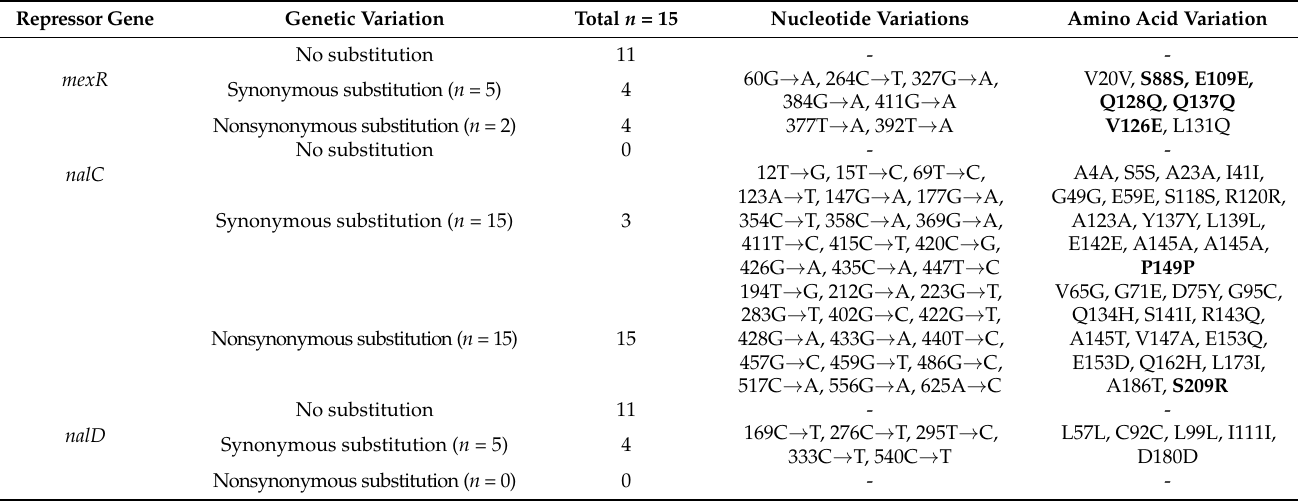
Table 3. Substitutions identified in the mexR , nalC , and nalD repressor genes in P. aeruginosa strains.